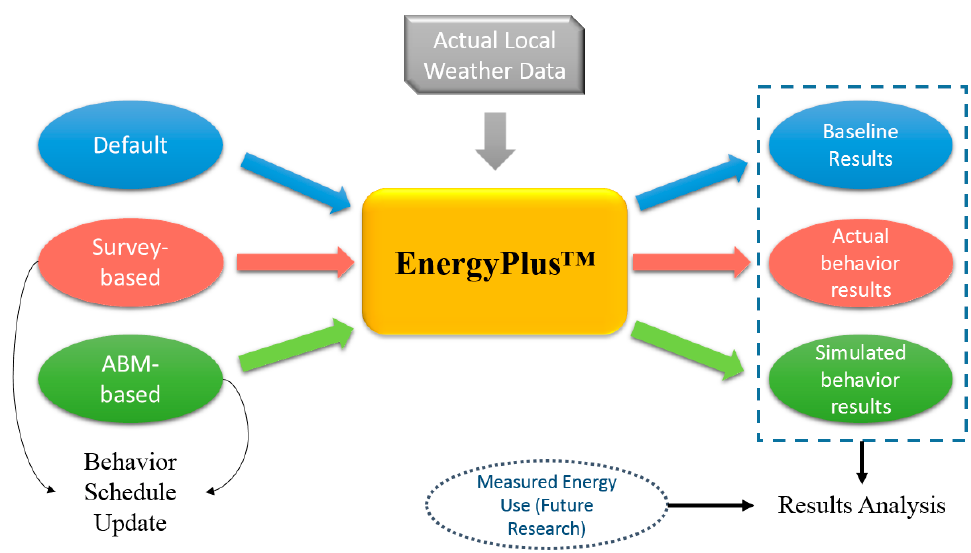
Figure 4. Simulation scenarios for building performance analysis.